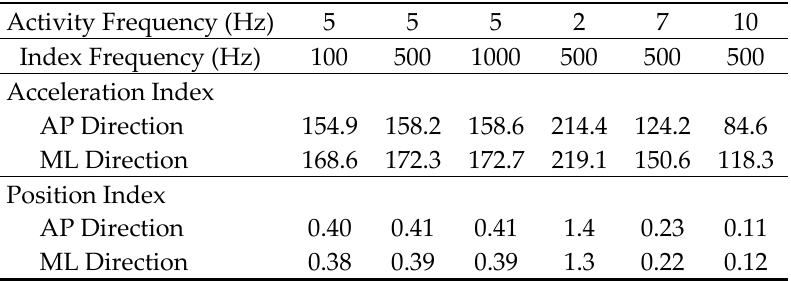
Table 2. Mean of acceleration, and position indices during static balance test, according to different combinations of activity and index